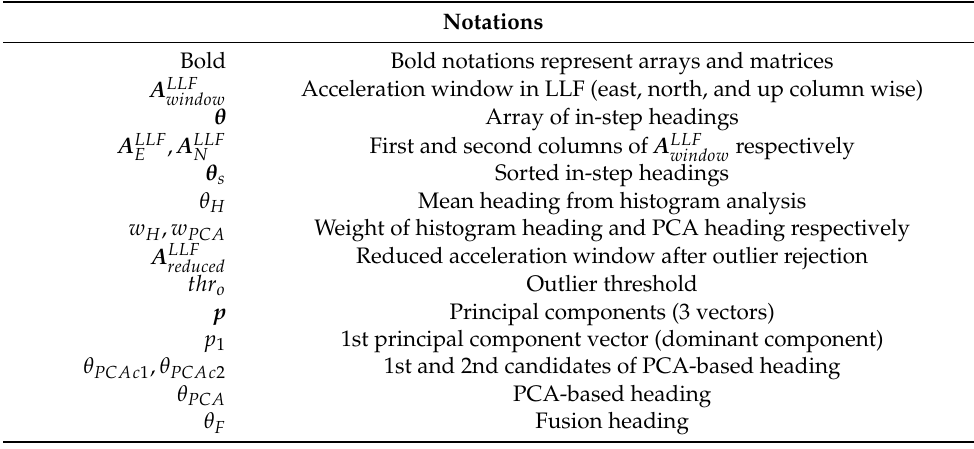
Table 1. List of notations used in the heading estimation algorithm.